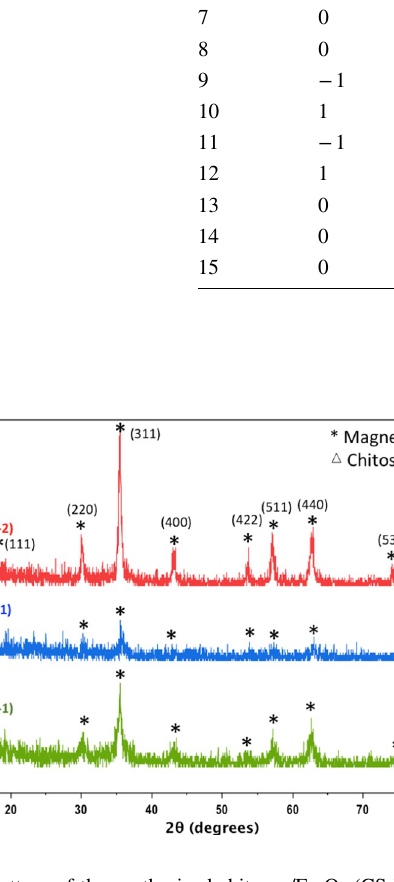
Fig. 2 XRD pattern of the synthesized chitosan/Fe particles composite material A CS-M-(2:1), B CS-M-(1:2) and C